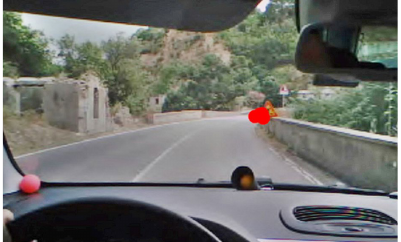
Figure 6. The work zone signage is properly gazed, even if its position close to the inner edge of the curve has facilitated this